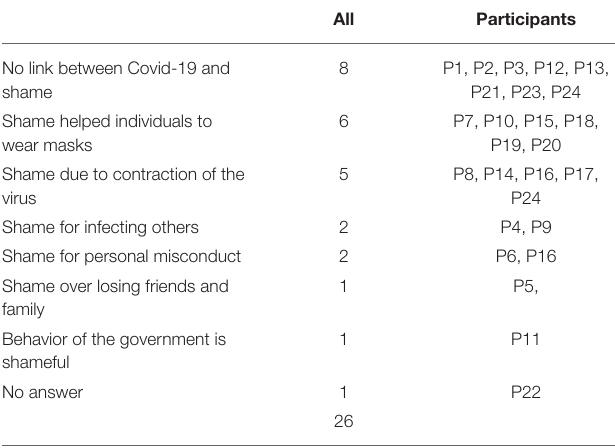
TABLE 3 | The role of shame.